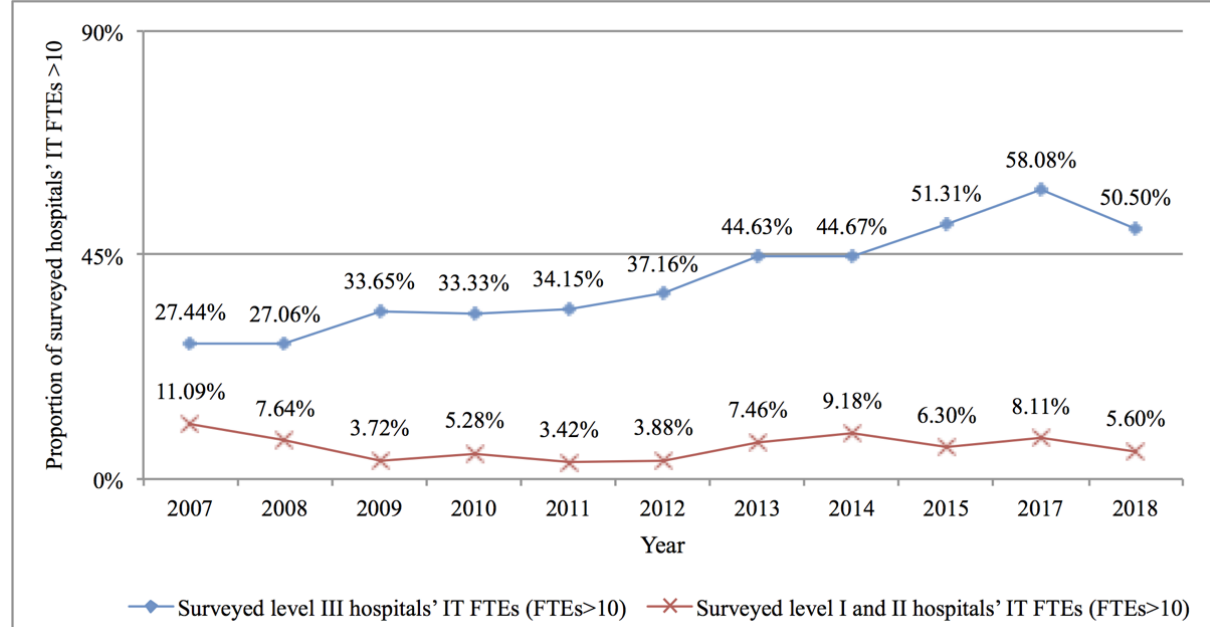
Figure 4. Information technology centers with 10 or more staff members in China’s level III hospitals and hospitals below level III from 2007 to 2018. IT: information technology; FTE: full-time